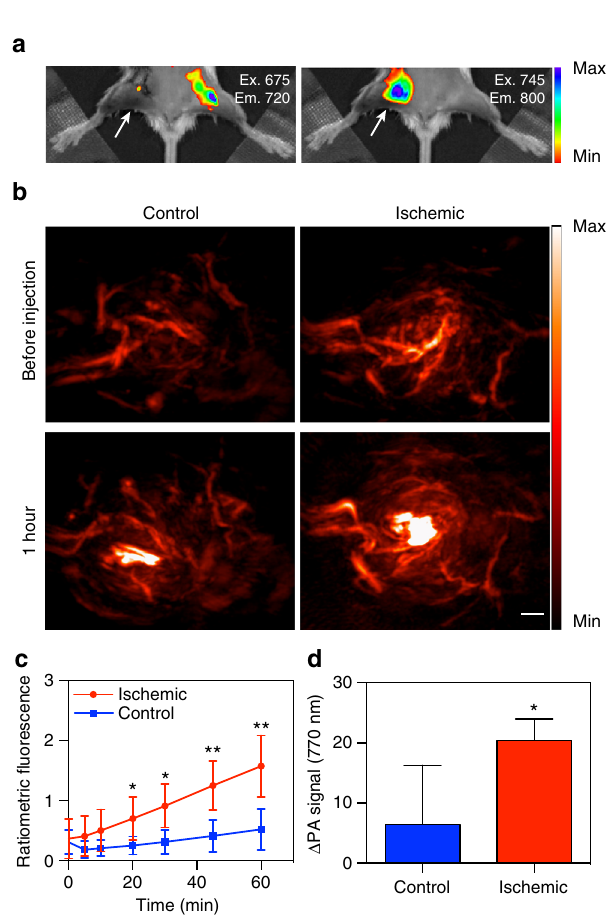
Fig. 7 In vivo imaging of a murine hindlimb ischemia model with HyP-1. a Fluorescence (IVIS spectrum) images acquired of hindlimb ischemia mouse model (right leg) 1 h following intramuscular injection (50 μ L, 50 μ M) of HyP-1 in both legs. Images were acquired using 675/720 nm and 745/800 nm fi lter sets. Mouse imaged in supine position, arrows indicate ischemic tissue. b PA images (770 nm) of the ischemic and control leg before and 1 h following injection of HyP-1 (50 μ L, 50 μ M). Scale bar represents 2 mm. c Time-dependent ratiometric fl uorescence increase of ischemic and control limbs ( n = 5). d Time-dependent increase of PA signal of ischemic and control limbs ( n = 4). Results with error bars are represented as mean ± SD. * p < 0.05, ** p <